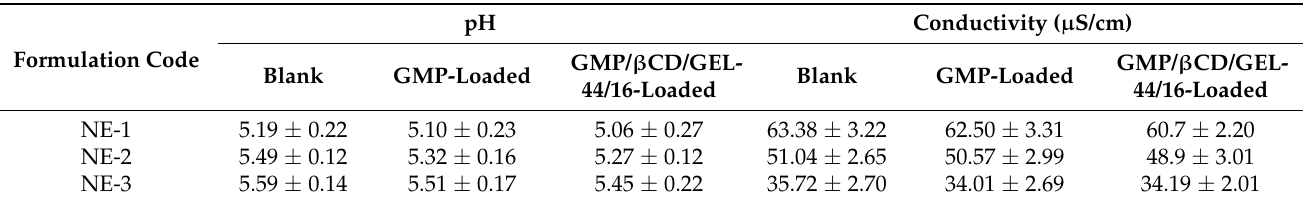
Table 5. pH and electrical conductivity investigation of blank (B), glimepiride-loaded (GMP), and inclusion complex-loaded (IC) nanoemulsions (Mean ± SD, n = 3).